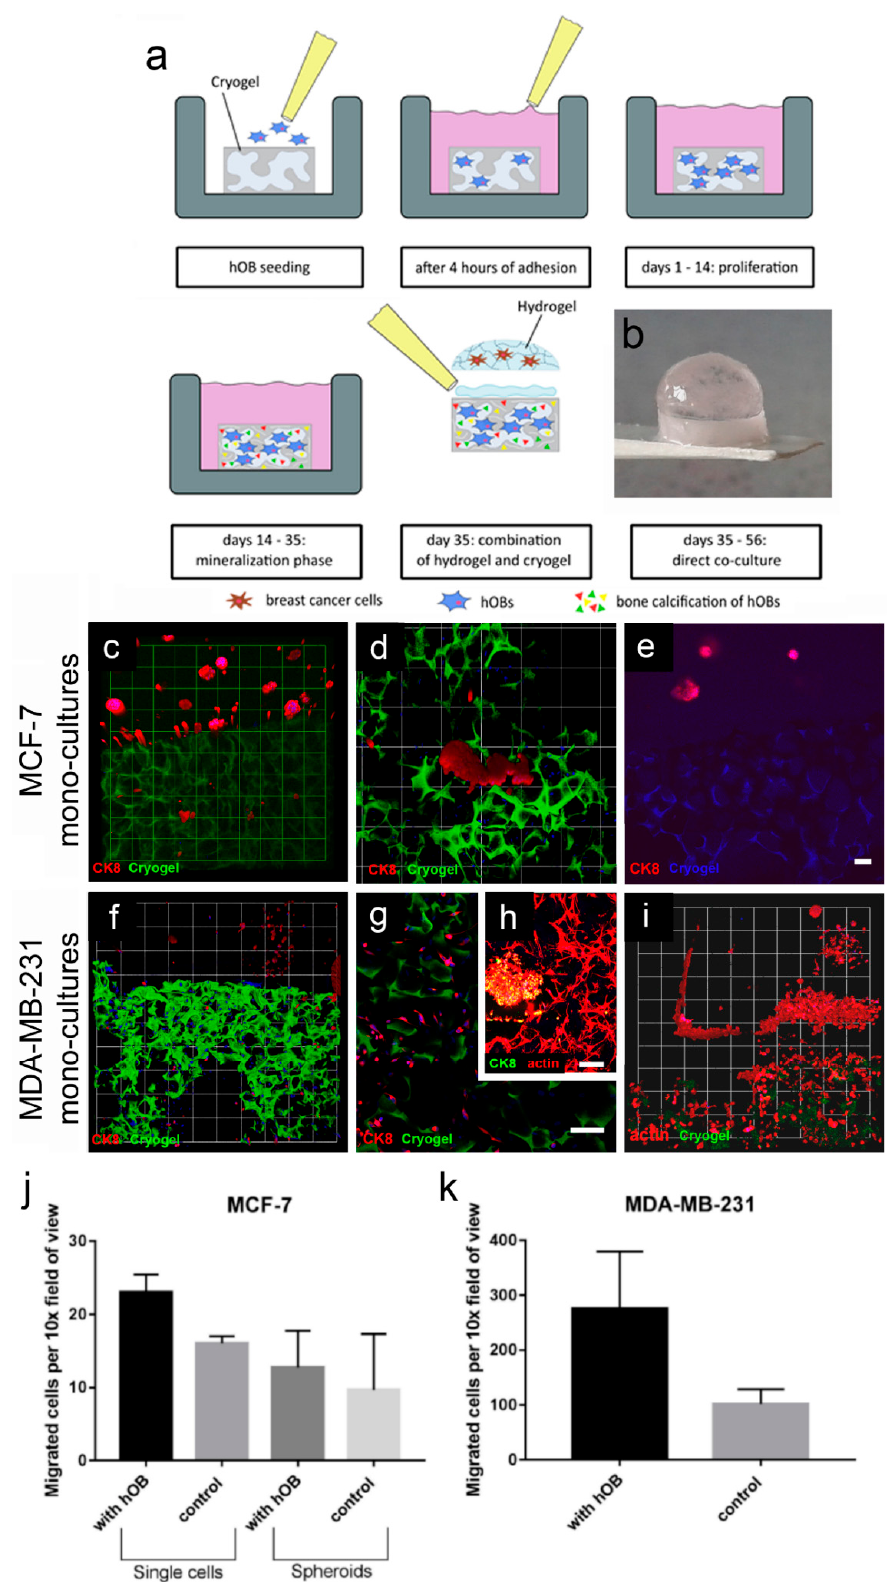
Figure 8. MCF-7 and MDA-MB-231 monocultures grown in a 3D–3D coculture model. ( a ) Schematic showing generation of the 3D–3D coculture model: hOBs were seeded onto cylindrical cryogel scaffolds. After 4 h of initial adhesion, 1 mL of hOB growth medium was added to each sample and they were cultured for 14 d. Next, the hOBs were stimulated in the mineralization phase (days 14–35). ( b ) At 35 d, hydrogels with various cell types were attached on top of the cryogel scaffolds. ( c – e ) Representative 3D confocal images show MCF-7 monocultures (CK8, red) grown in a hydrogel–